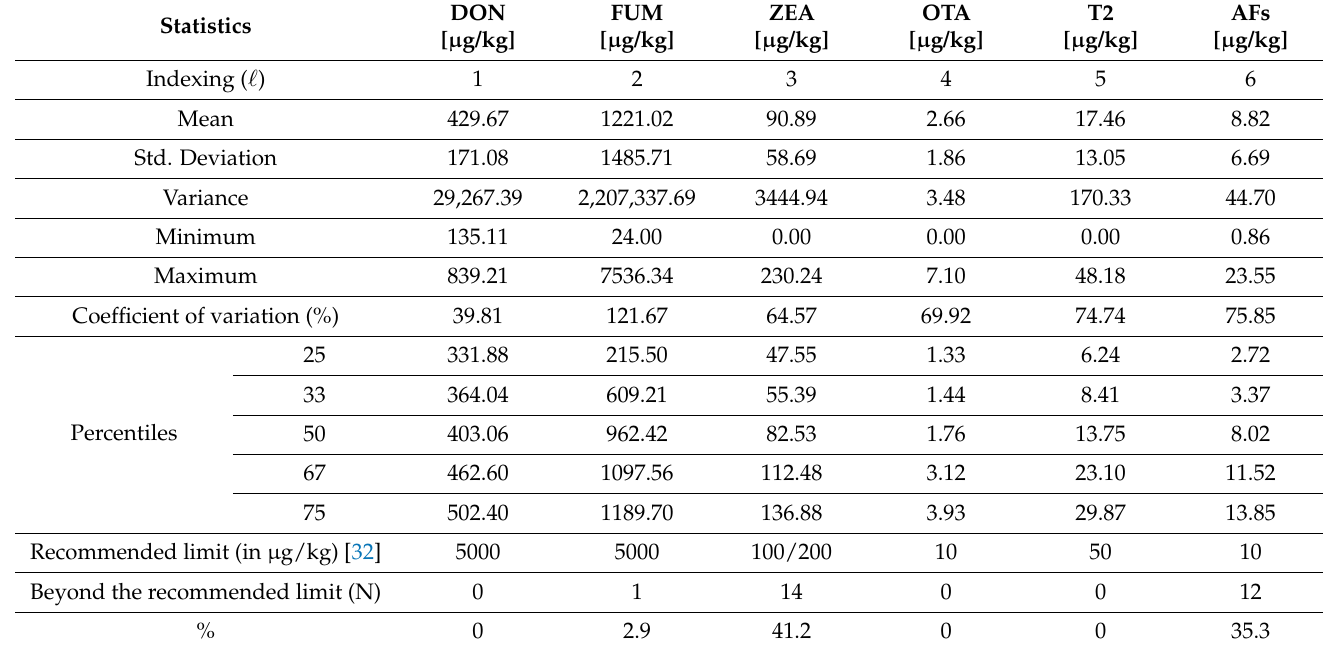
Table 5. Descriptive statistics and recommended limits of mycotoxins identified in the analyzed